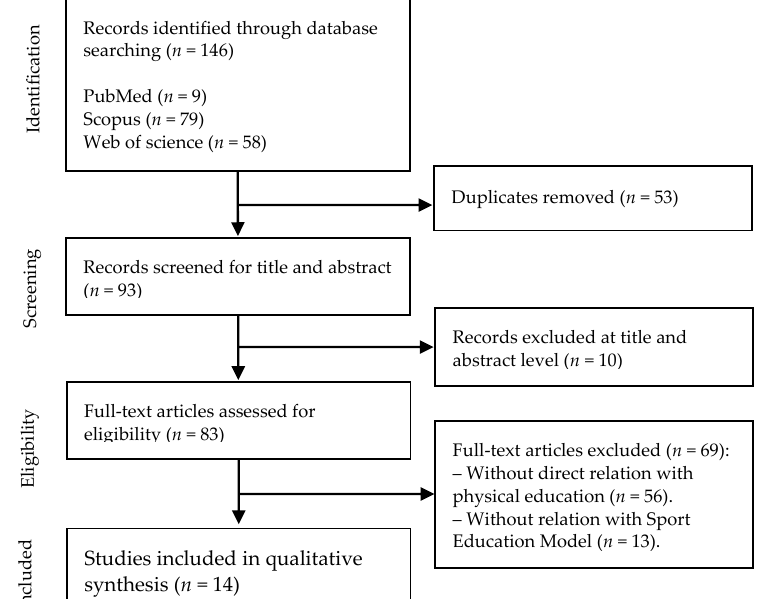
Figure 1. Flow diagram of study